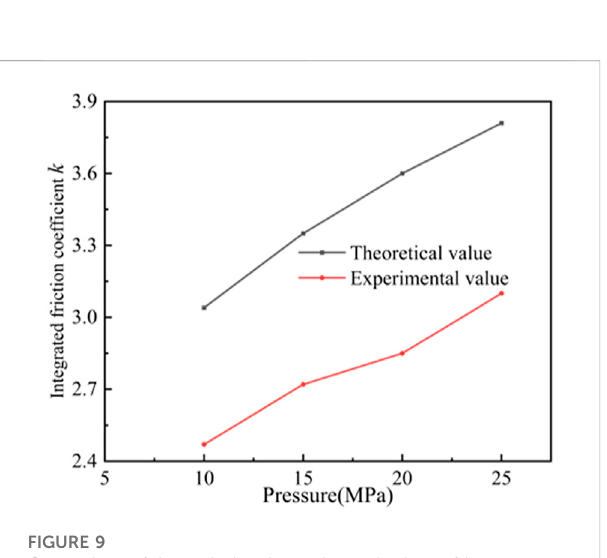
FIGURE 9 Comparison of theoretical and experimental values of k at 0.15